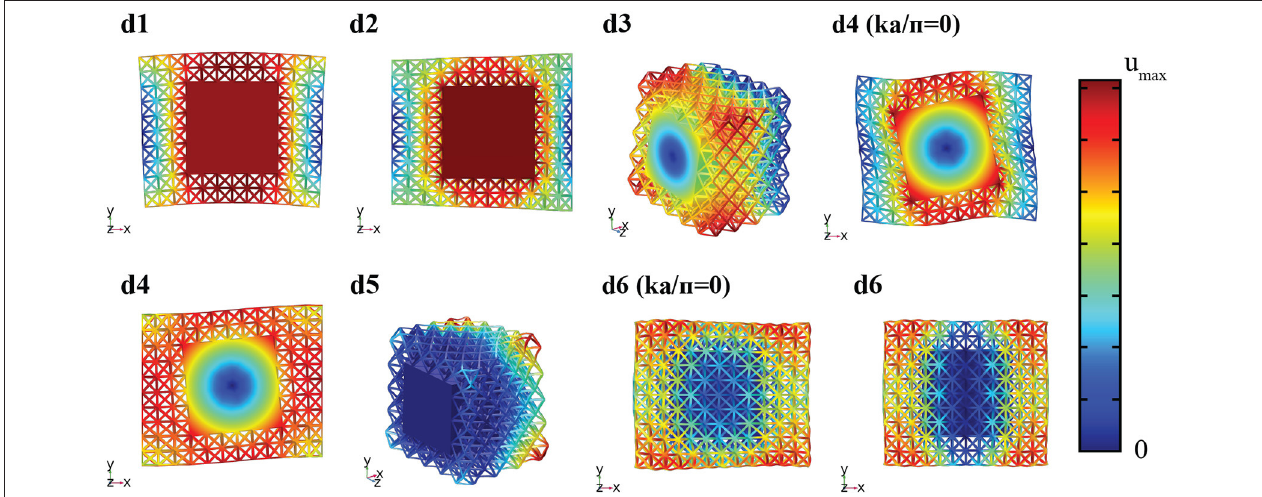
FIGURE 5 | Detailed view of octet modal displacements, according to Figure 4 . Geometries are cross-sectioned for a better description of motion. Modal displacements are taken at ka/ π 1 unless =